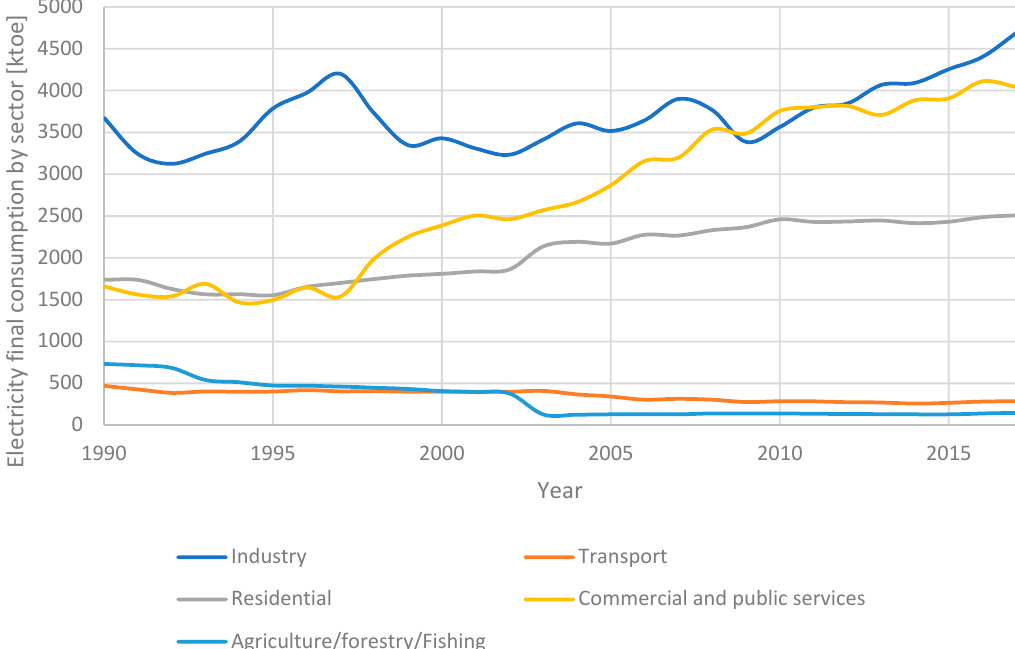
Figure 6. Final electricity consumption by economic sectors, ktoe, source: own study based on the data [32].